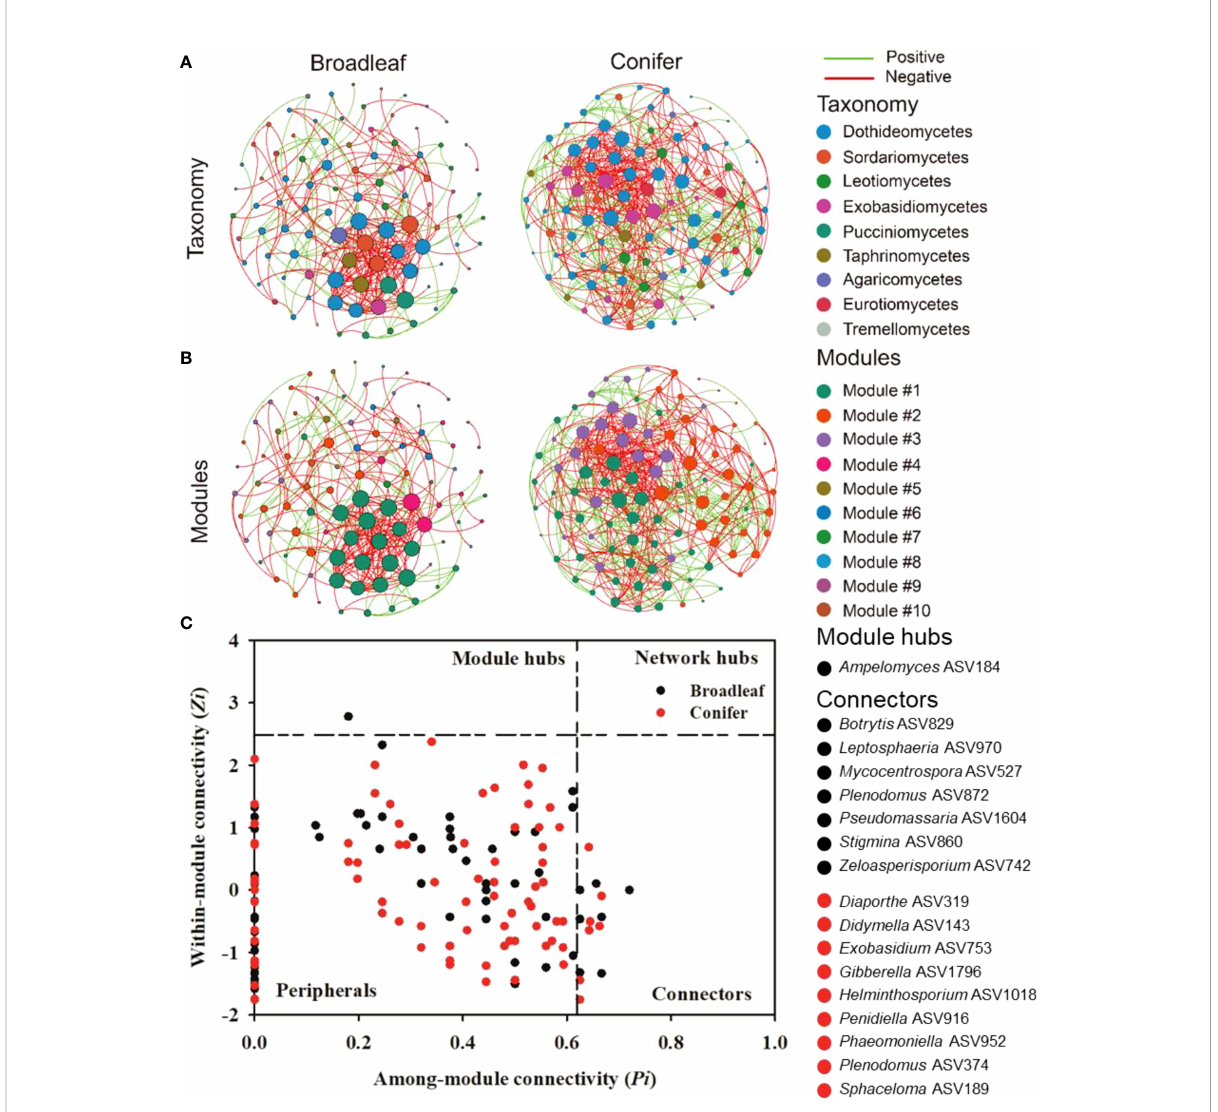
FIGURE 6 Taxonomic (A) , modular networks (B) , and topological roles of each ASVs in the fungal plant pathogenic co-occurrence networks (C) in broadleaf and coniferous tree species. The green (co-presence, positive) and red links (mutual exclusion, negative) in the co-occurrence networks represent signi fi cant Spearman ’ s correlations ( P <0.05). Each node in Fig. 6a and b represents one ASV. The size of each node is proportional to the degree. The node color indicates the corresponding taxonomic assignment at the class (A) and modular level (B) . The nodes in Fig. 6c with Zi > 2.5 but Pi < 0.62 are identi fi ed as module hubs, and those with Pi > 0.62 but Zi < 2.5 represent connectors. The network hubs are characterized with Zi > 2.5 and Pi > 0.62, and the peripherals are characterized with Zi < 2.5 and Pi < 0.62 according to Olesen et al., 2007. Nodes in broadleaf 10 (4 big modules), conifer 4 (3 big modules > 10% of the notes)